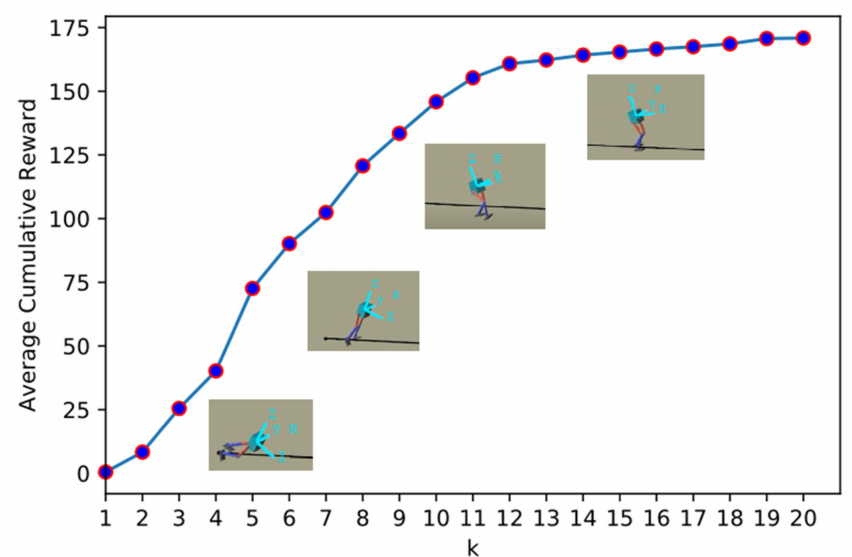
Figure 4. The optimization process of the iterative linear Gaussian controller (iLQG). With the increase in interaction data between the iLQG controller and the environment, more experiences are used to fit the dynamics, and the average cumulative reward of the iLQG agent is multiplying. When the interaction experiences accumulated to a certain amount, the performance improvement of iLQG is unobvious.